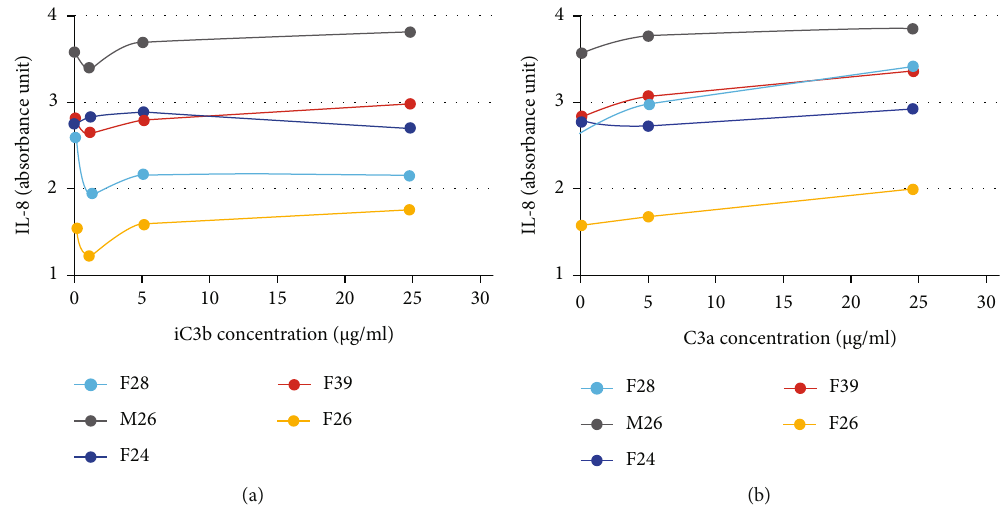
Figure 5: Stimulation of peripheral blood mononuclear cells from 5 healthy subjects for 24 hours using (a) iC3b and (b) C3a, and the resulting level of IL-8 in the conditioned medium in relation to the IL-8 level induced by the diluent